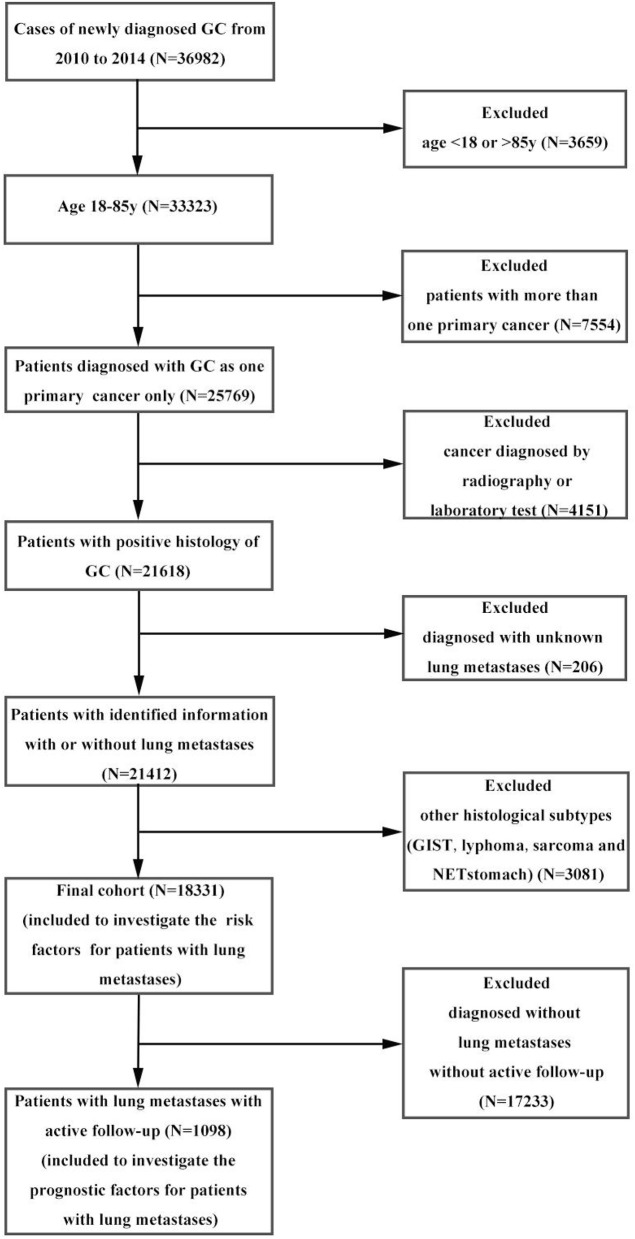
Data extraction flowchart from the SEER database.